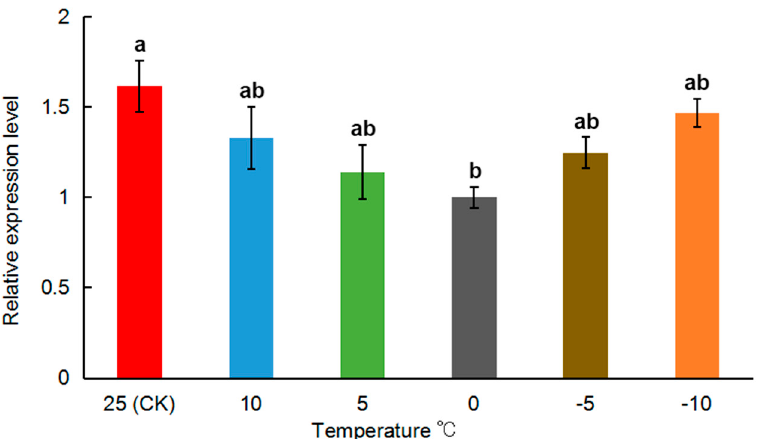
Figure 5. Relative expression of MRLC-sqh in O. communa after exposure to different temperature conditions over a 3-h period. The expression fold changes were related to the 0 °C. The transcript level of MRLC-sqh was normalized against that of RPL4 . Relative expression is represented as mean ± SE. The values marked with different letters are significantly different based on one-way ANOVA and LSD analyses.